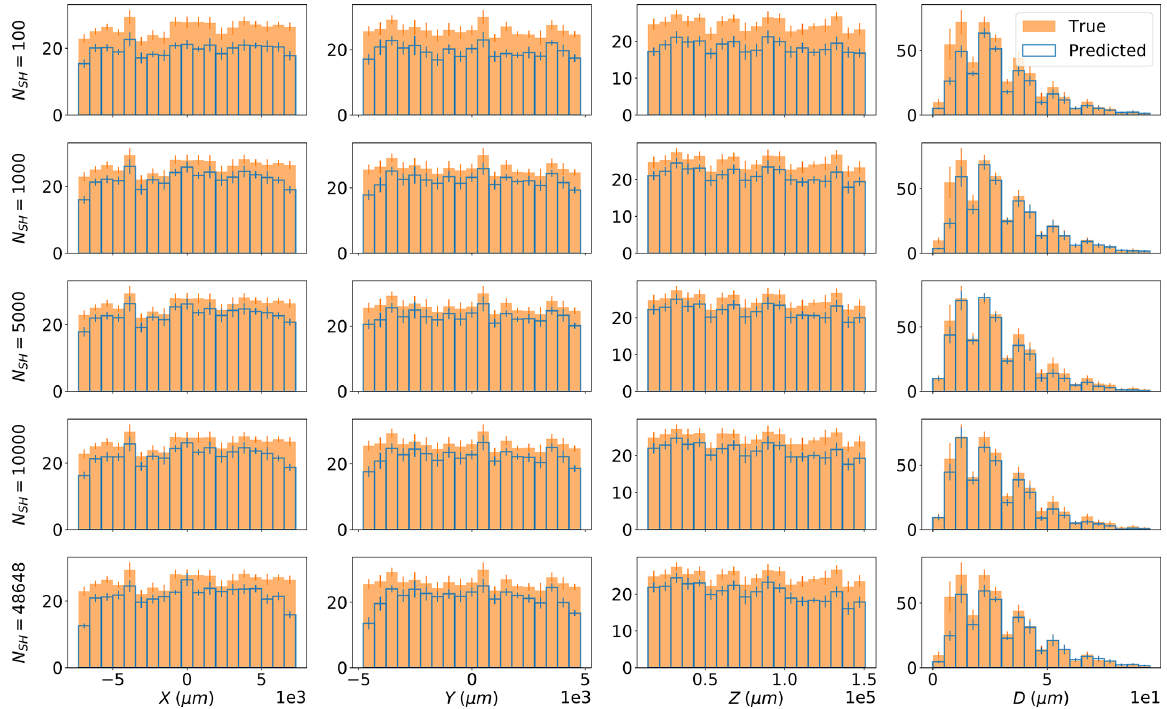
Figure 9. Histograms for the particle coordinates and diameter are shown in each column comparing the models’ predictions (blue outlined boxes) against the true values (solid orange boxes), computed using the 10 test holograms. The rows show the results for models N SH = 100, 1000, 10000, and 48648, respectively. The value of each bin and the error bar were computed by taking the mean and standard deviation across the 10 holograms. The match distance threshold was